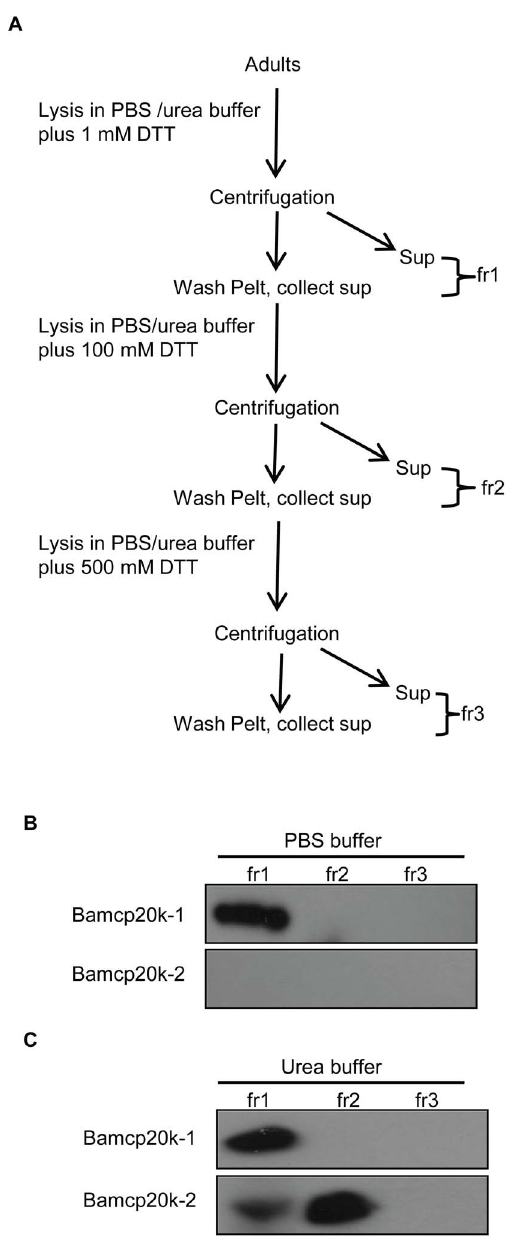
Figure 8. Solubility of adult Bamcp20k-2 was dependent on DTT concentration. (A) and (B) Adult barnacles were homogenized in PBS or urea buffer with different concentration of DTT, as mentioned in the methods section. Equal proportions from each fraction were collected for Western blot against Bamcp20k-1 and Bamcp20k-2. Fr: